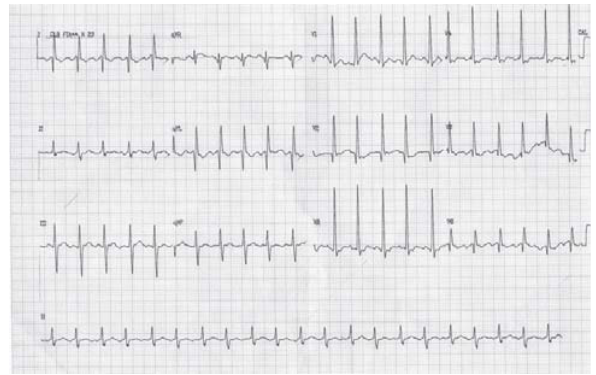
Fig. 1 – Eletrocardiograma com onda P negativa em D1 e AVL sugerindo situs inversus